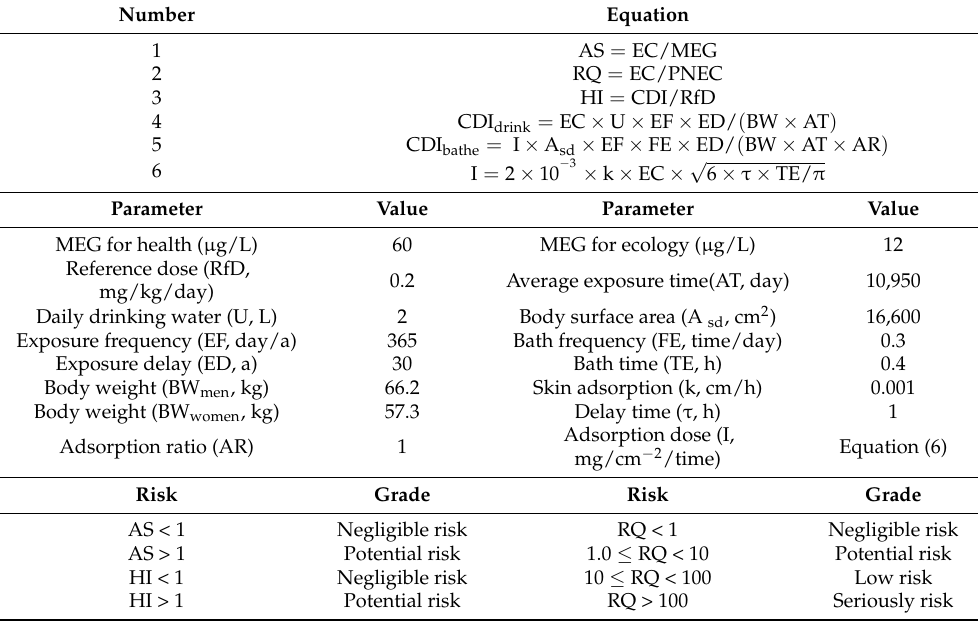
Table 1. The key criteria and parameters for the risk assessment of BBP.